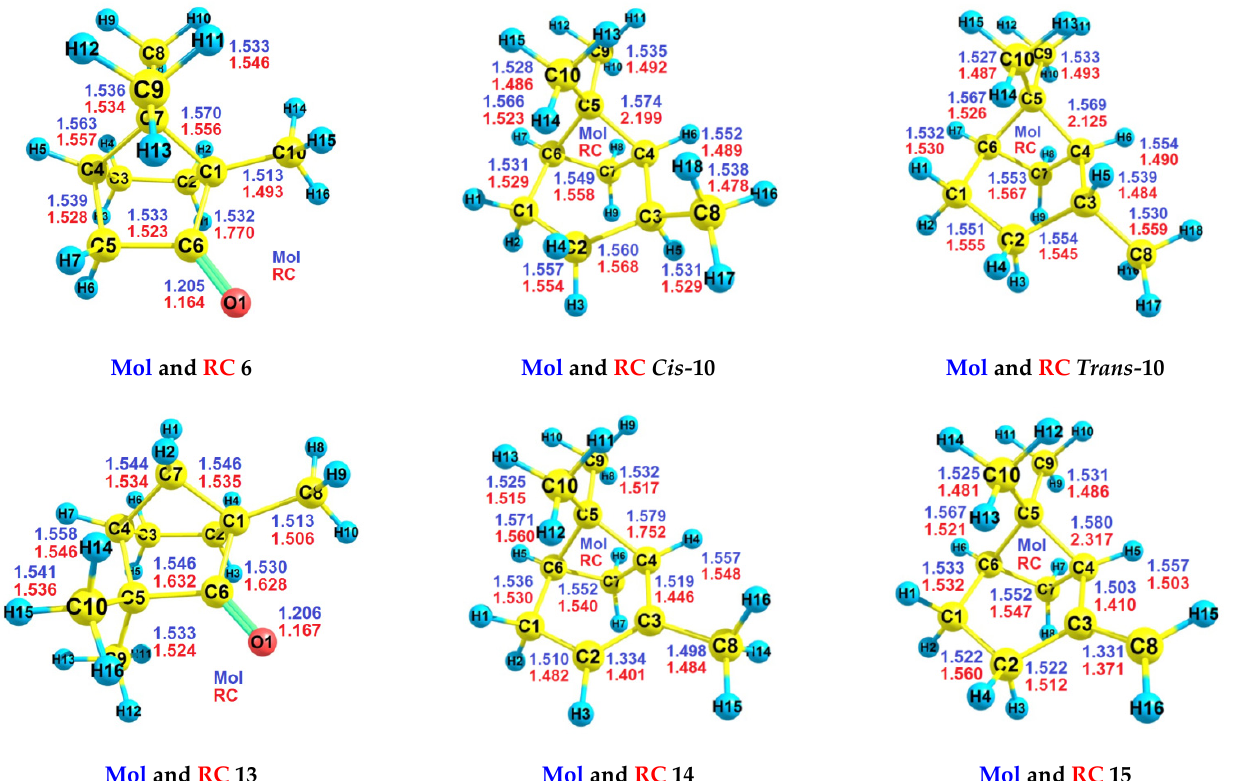
Figure 5. The DFT calculated geometries of RH 2 – 5 molecules ( Mol ) and its radical cations ( RC ), bound lengths in Å.